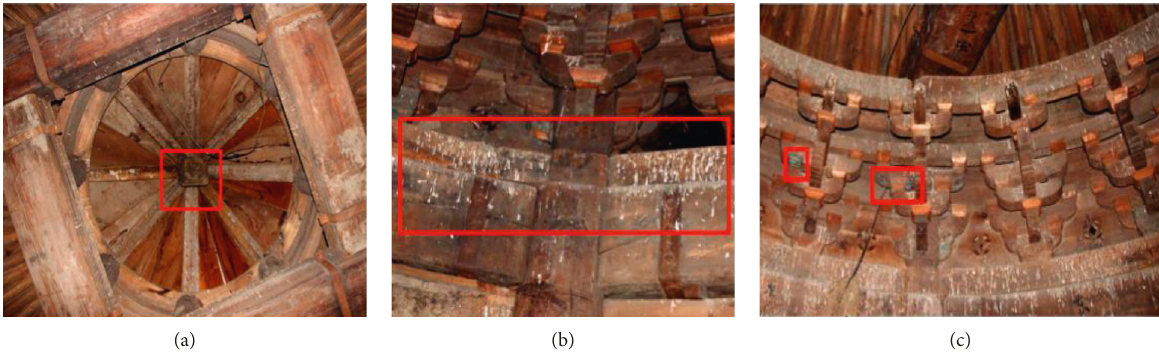
Figure 2: Wooden component damage at the top of the pavilion due to (a, c) mold and (b) bird